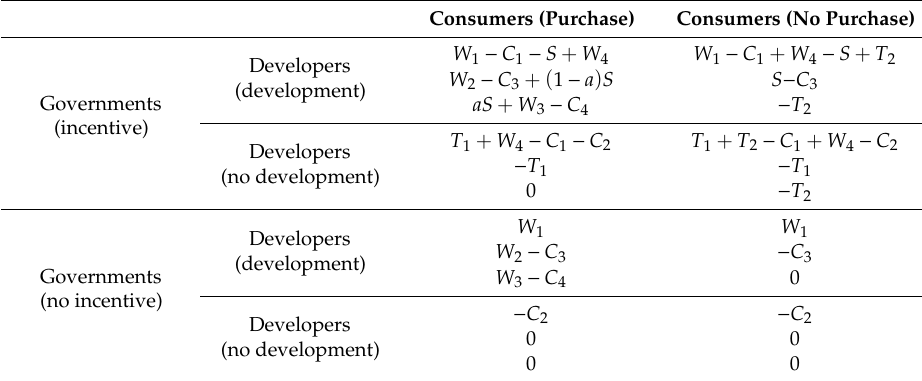
Table 2. The payment matrix of the game model of governments, developers, and